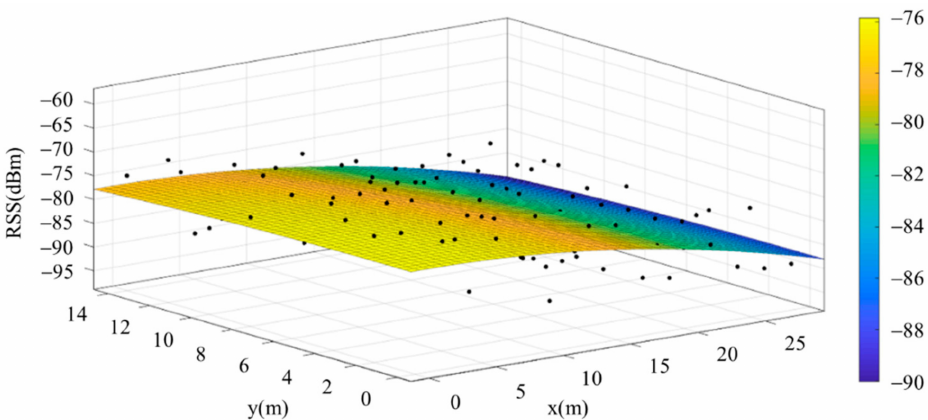
Figure 18. Fitting Model for Same Base Station Using Data Collected Facing